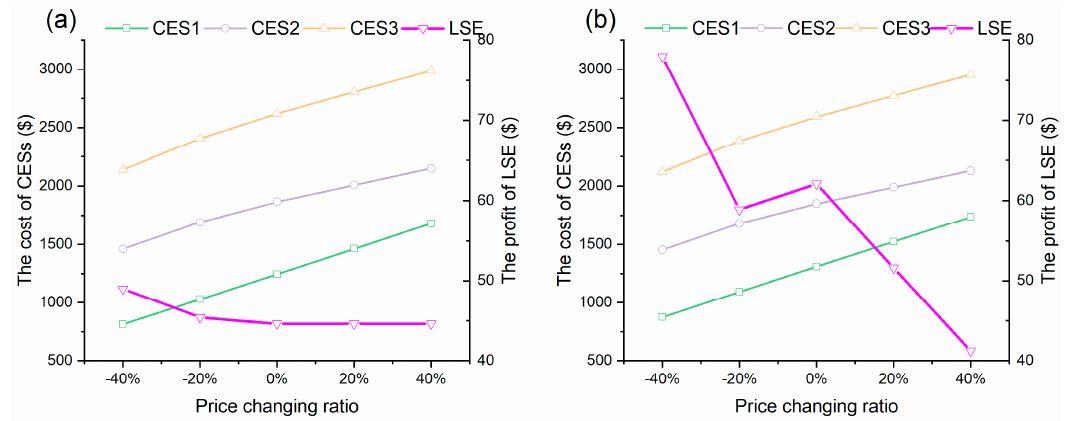
Figure 9. Influence of the natural gas price on the economic performance of the LSE and CESs: ( a ) centralized coordination scheme; ( b ) decentralized coordination scheme.